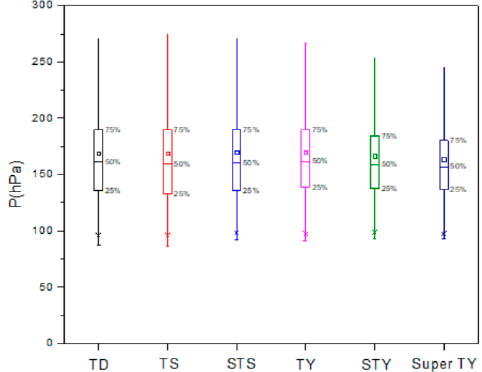
Figure 8. Statistics of ice cloud top pressure by different TC intensity.